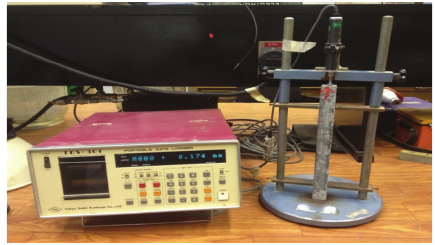
Figure 1: Setup for measuring total